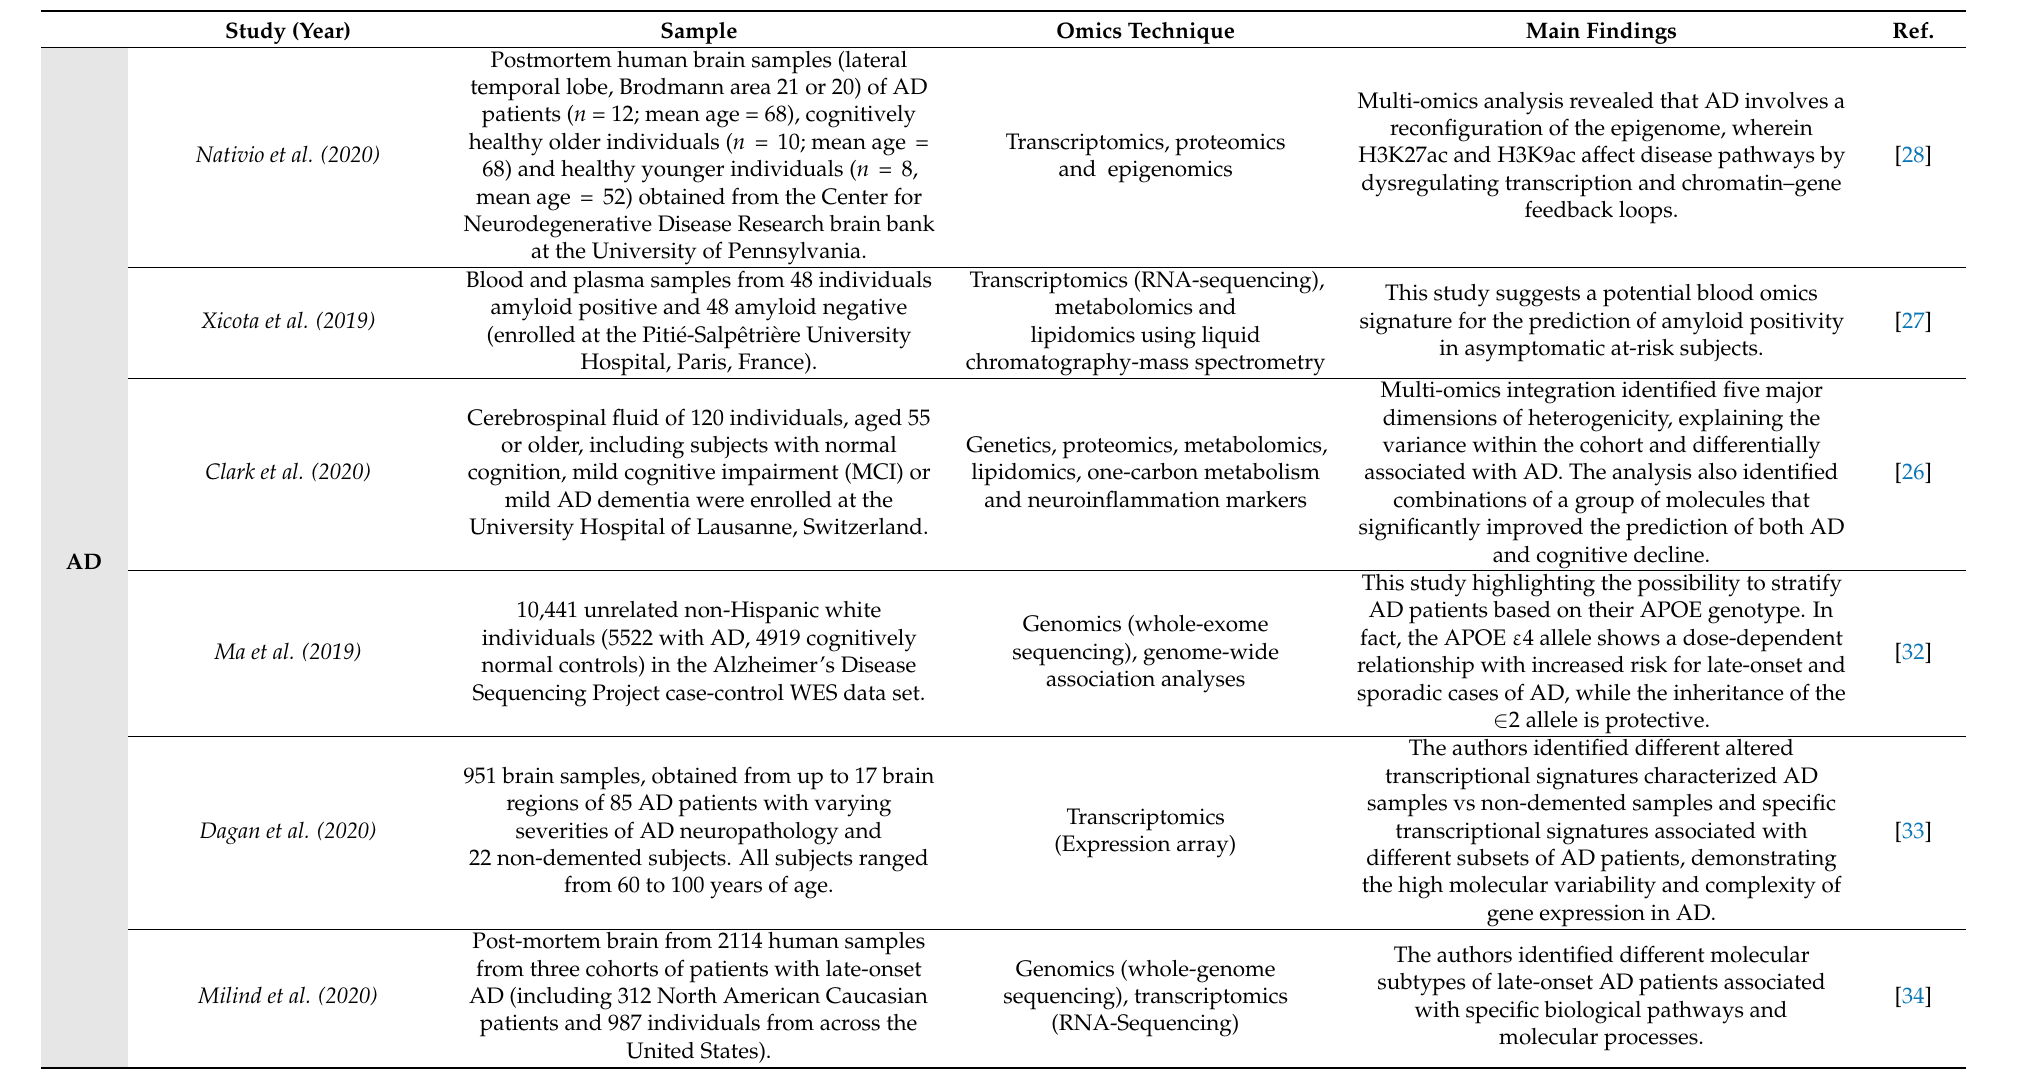
Table 1. Exemplary studies of omics approaches and/or their integrative analysis for stratifying NDs into their different molecular